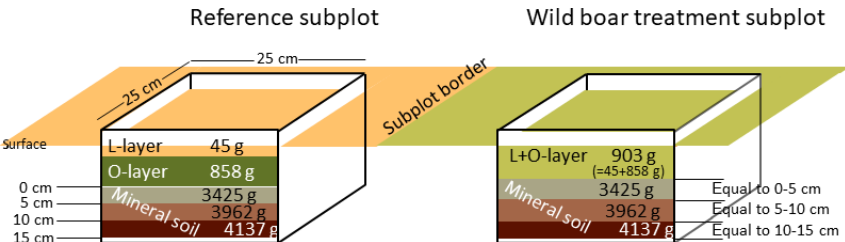
Figure 1. Equal mass sampling of forest floor (L and O layer) and mineral soil (0–15cm depth). Weights refer to the mean weight of the different layers and soil depth increments as obtained in the field.